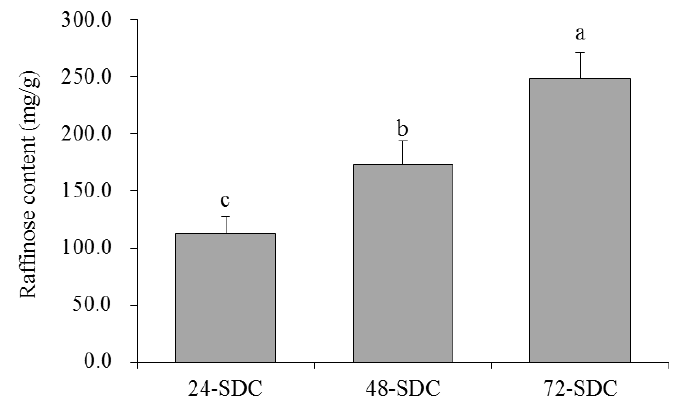
Figure 2. Raffinose content of Shuidouchi at different fermentation times. Values presented are means ± standard deviation ( n = 3). Different letters indicate significant differences ( p < 0.05) between each group, and the same letters indicate that there is no significant difference ( p > 0.05) between each group according to Tukey’s test for multiple comparisons. 24-SDC: 24-h-fermented Shuidouchi; 48-SDC: 48-h-fermented Shuidouchi; 72-SDC: 72-h-fermented Shuidouchi.